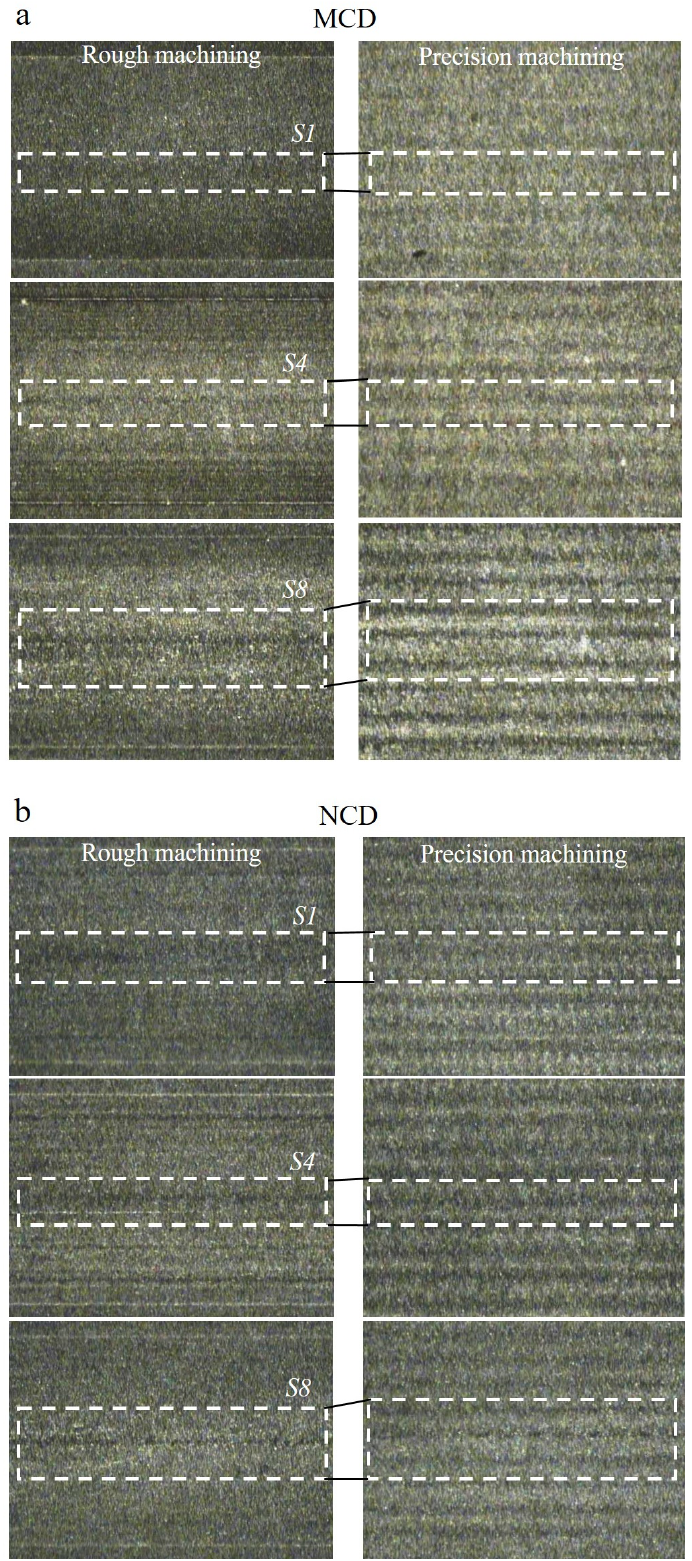
Figure 16. Machined surfaces compared to cutting length using ( a ) MCD and ( b ) NCD-coated tools. (S1, S4 and S8—Each section of cutting length; White box—The contact area between the center of the cutting edge and the machining